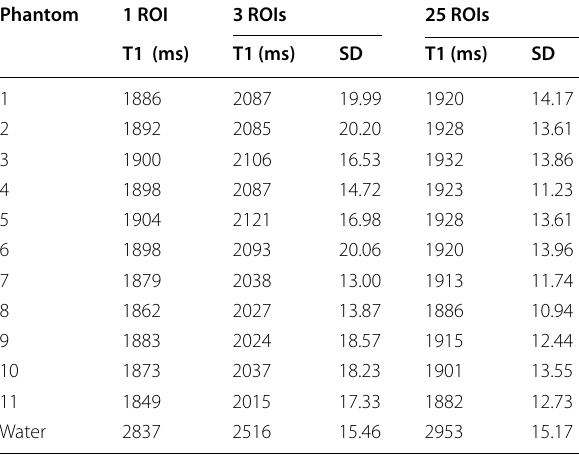
Table 6 T1 values of all agar gel phantoms at TP1 Phantom